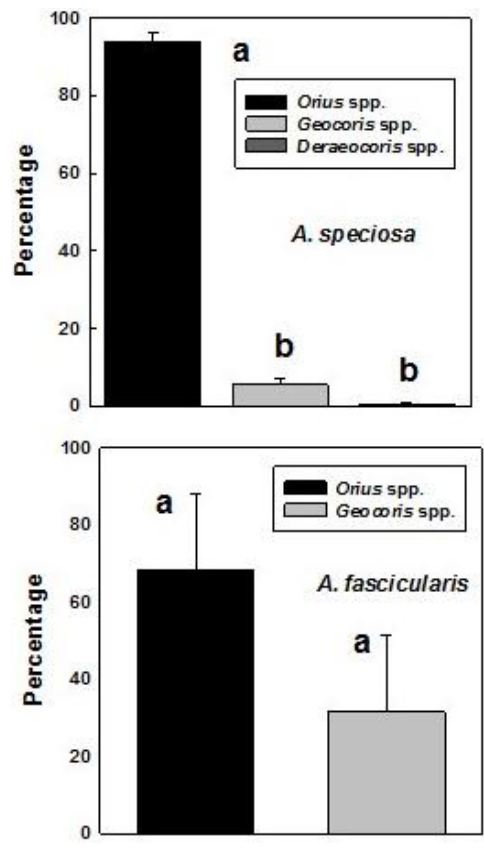
Figure 5. Mean (±SE) percentage per season of predatory bug genera ( Orius spp., Geocoris spp., Deraeocoris spp.) trapped on flowering Asclepias speciosa and Asclepias fascicularis during 2010–2013 ( Asclepias) and 2012 – 2014 ( fascicularis ). Bars denoted by different letters are significantly different ( p < 0.001).